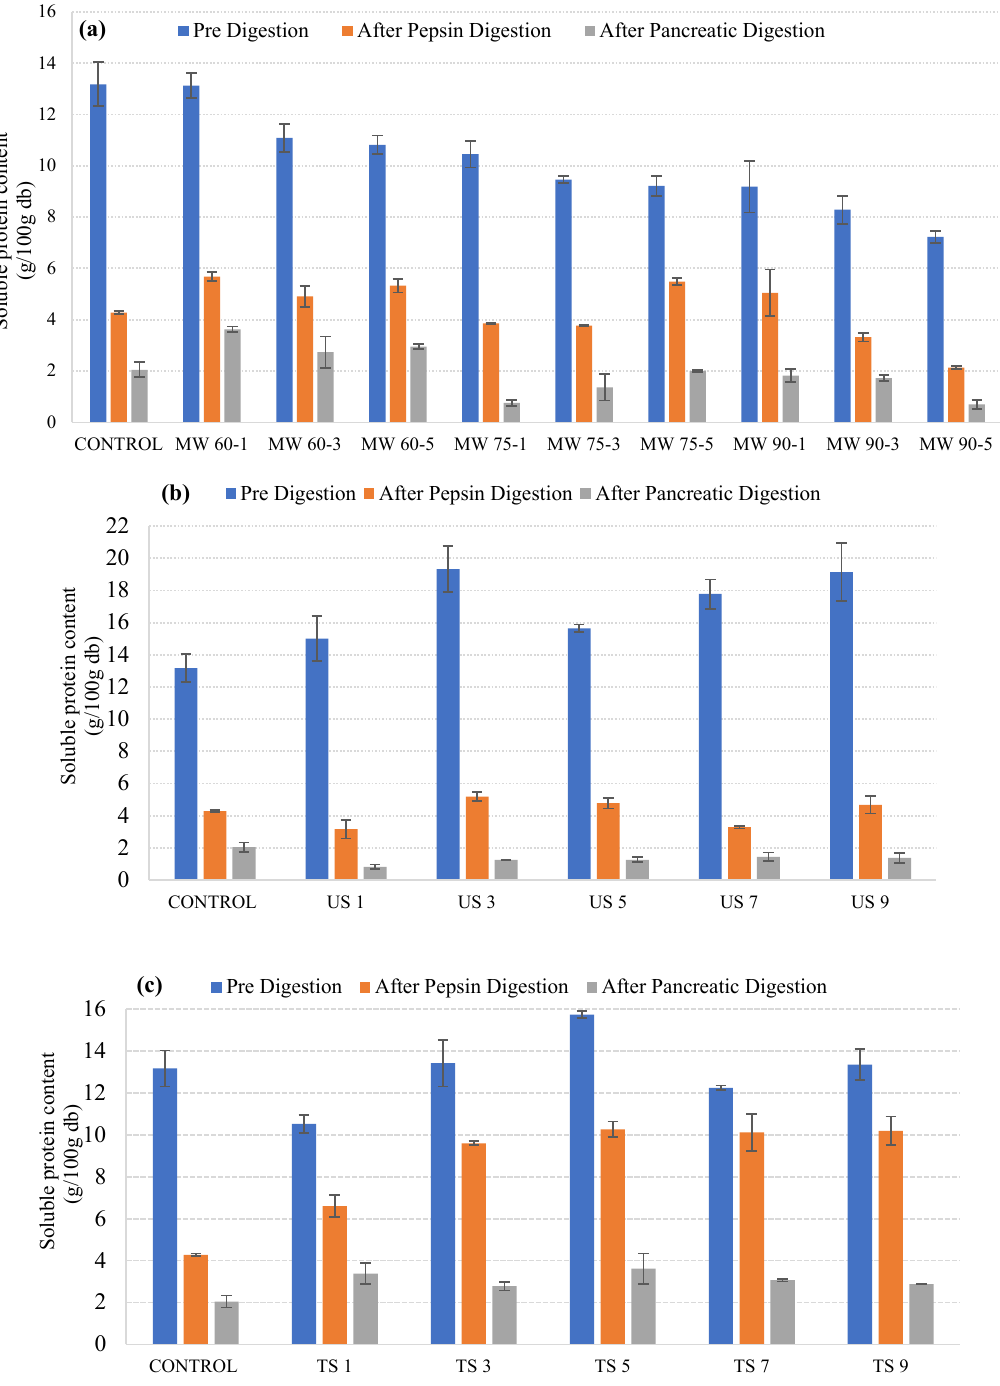
Figure 2. Protein content changes of microwave-processed ( a ), ultrasound-processed ( b ), and thermosonication-processed ( c ) cow milk under different conditions (pre-digestion, after pepsin digestion, and after pancreatic digestion).